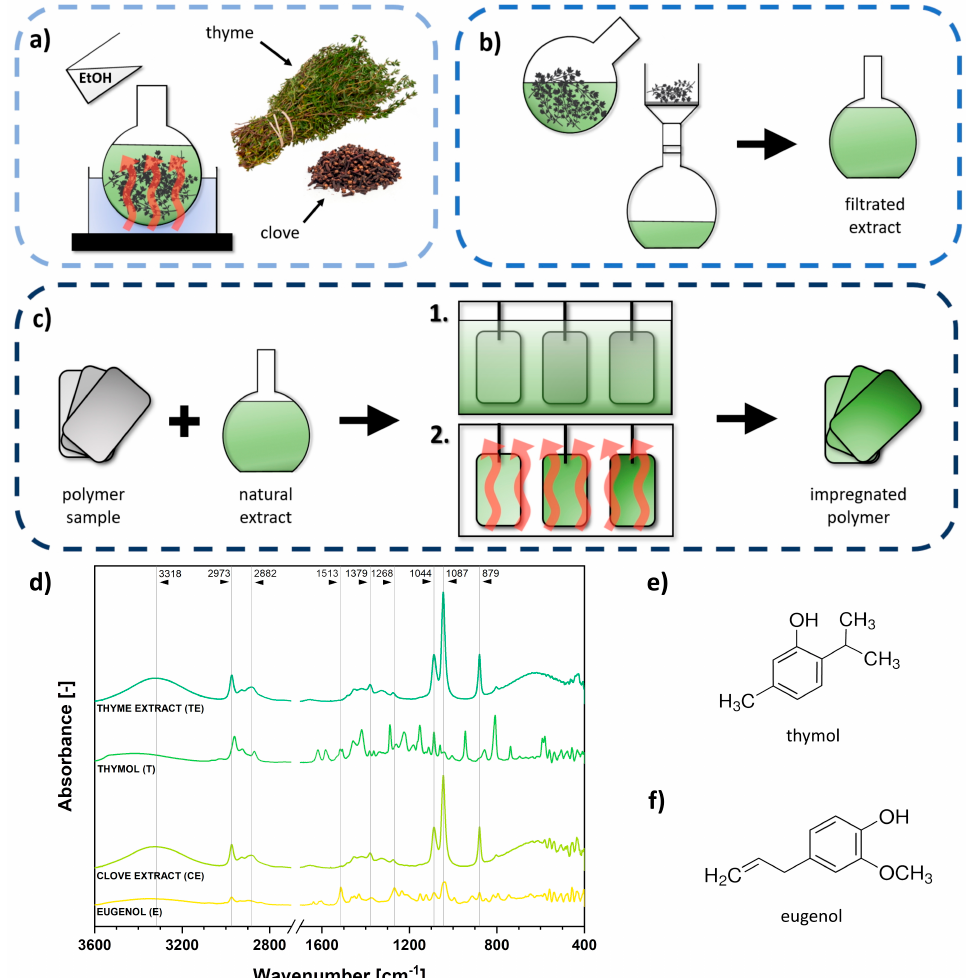
Figure 1. Scheme of ethylene–norbornene copolymer (EN) and poly(lactic acid) (PLA) impregnation with plant extracts: ( a ) extraction of phytochemicals in ethanol environment (50 °C, 24 h), ( b ) filtration process and purification, ( c ) proper impregnation of plastic samples with thyme/clove extracts or thymol/eugenol solutions (bath: 50 °C, 24 h; drying: 30 °C, 18 h). Solutions prepared in this study were analyzed with Fourier–transform infrared spectroscopy ( d ), and the chemical structures of two main chemical compounds present in thyme and clove, respectively, thymol ( e ) and eugenol ( f ), are shown next to the